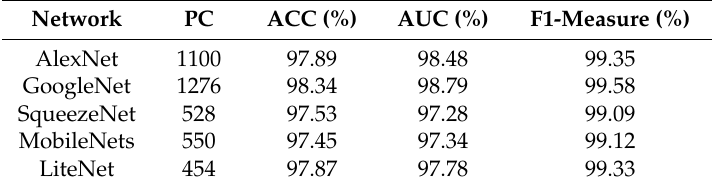
Table 6. Comparison of four CNN-based networks for set A with the ten-fold cross-validation method.